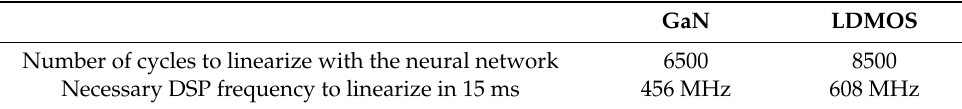
Table 6. Required resources to linearize with a neural